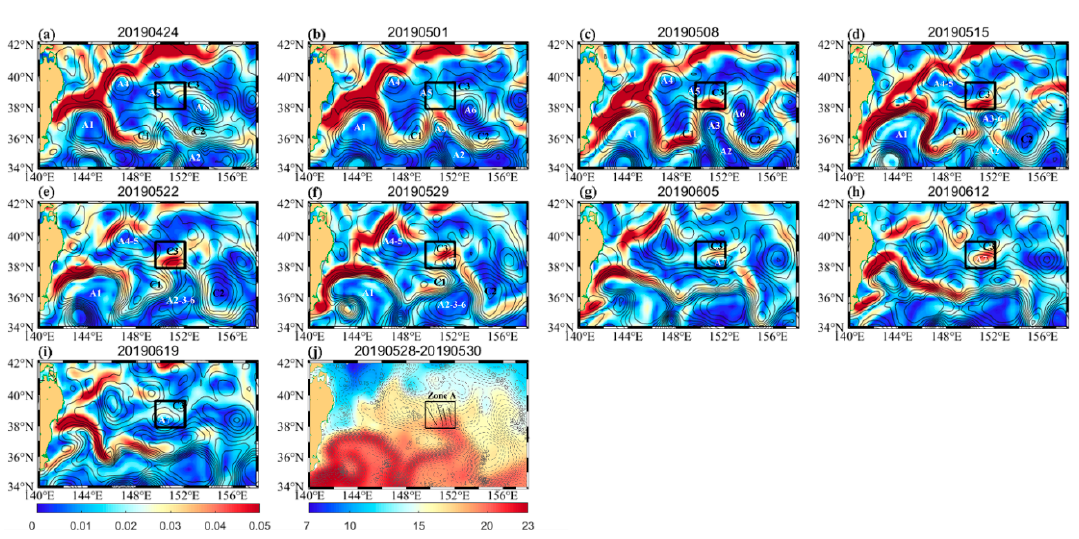
Figure 2. ( a – i ) Daily SST gradients (shading in °C/km) and SLA (contours in m) east of Japan are shown every seven days from the end of April to the end of June in 2019. Intervals for contour lines are 0.1 m. Black boxes indicate the observation area. Some eddies are labeled as follows: anticyclone eddies (A) in white and cyclone eddies (C) in black; if two eddies merged, we named them “Ax-xx” or “Cx-xx”. ( j ) Mean SST (shading in °C) and ADT (contours in m) east of Japan during the observation period. Intervals for contour lines are 0.05 m. Black box is the observation area named Zone A. Black dots are the observation stations.